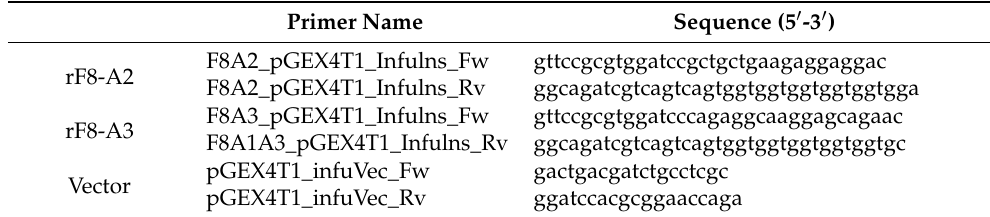
Table 1. Primers used in this